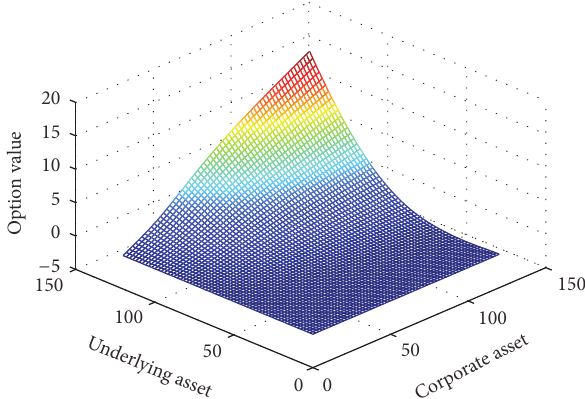
Figure 1: Option value with different underlying assets and corpo- rate assets.